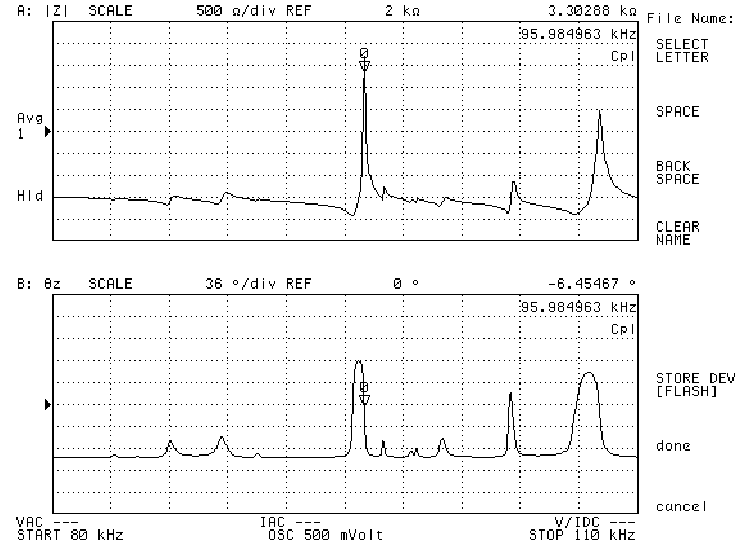
Figure 13. The experimental frequency response functions of the designed ultrasonic transducer with horn diameter 6mm and horn holder diameter 13.0 mm and fixed by four clamp screws. The impedance spectrum is plotted as a function of the frequency between 80 kHz and 150